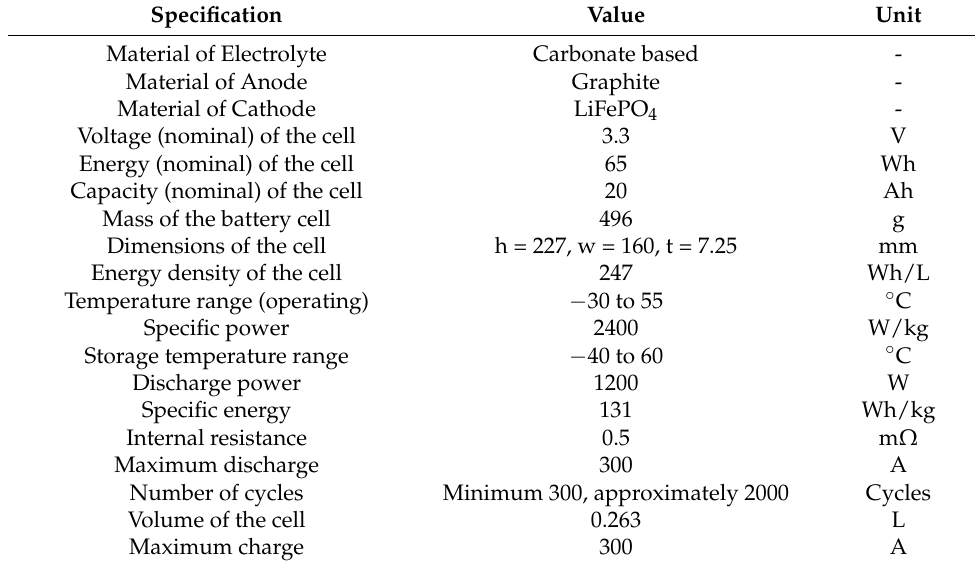
Table 1. Specifications of battery used for testing and